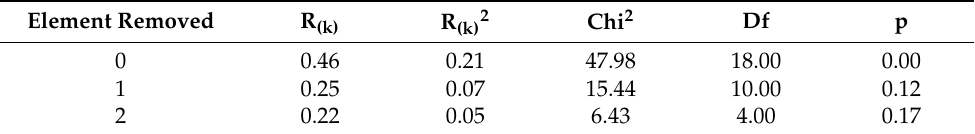
Table 2. Barlett test for V (4) .